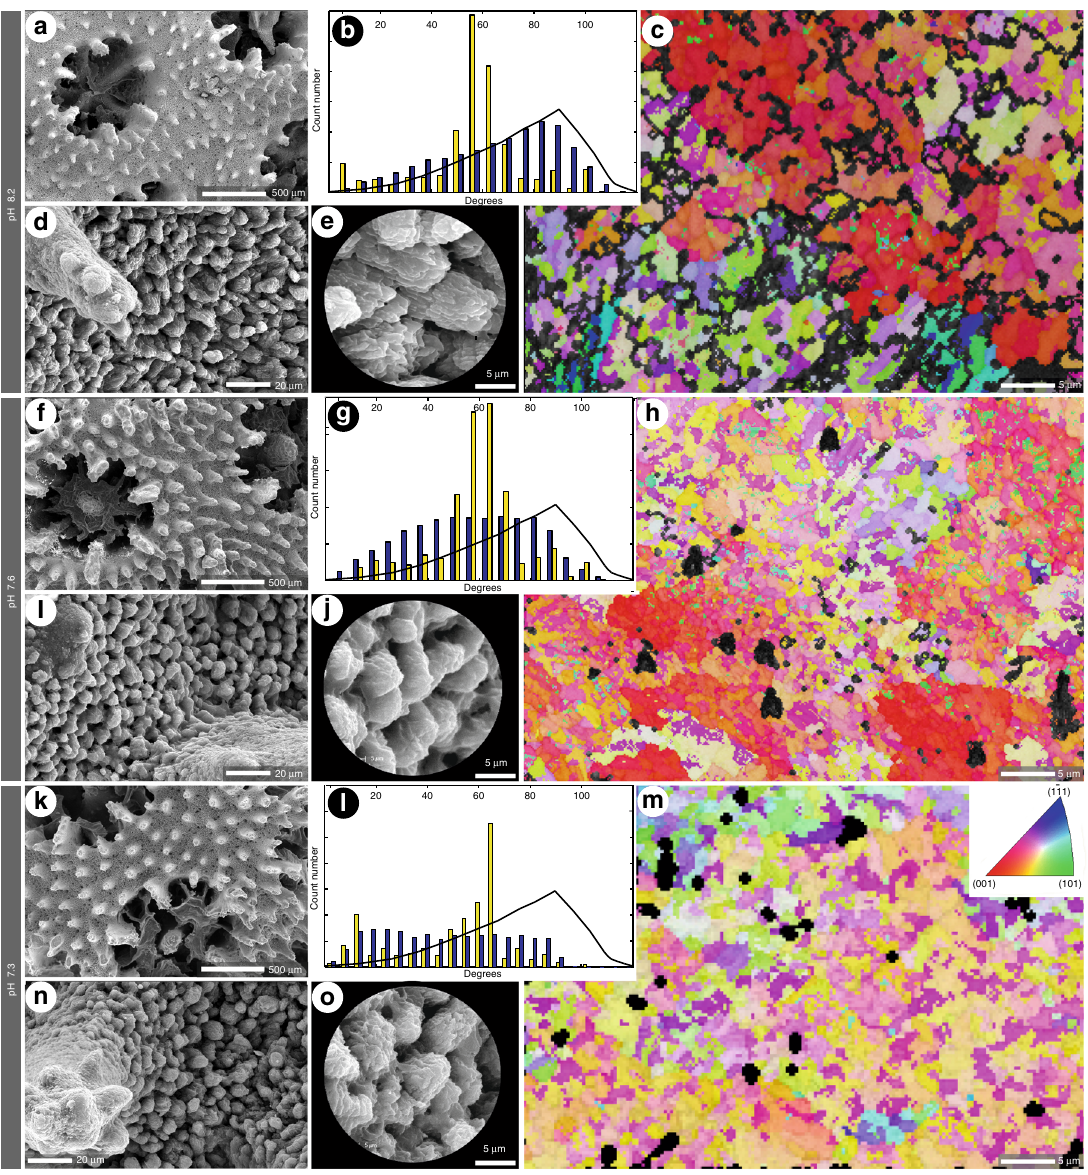
Fig. 1 Structural features of Stylophora pistillata cultured at pH conditions. Overall view of the colony surface with corallites and spiny coenosteum ( a , f , k ). Enlargements of the coenosteum showing granulated surface composed by bundles of fi bres ( d , i , n ; details of the texture of bundles in zoomed areas ( e , j , o ). Note that the texture of bundles grown in 7.3 pH and 7.6 is more rounded than those grown in pH 8.2. EBSD orientation maps showing the crystallographic arrangement of thickening deposits crystals ( c , h , m ). Colour-coding assigns a colour to each possible orientation. Histograms ( b , g , l ) representing correlated (yellow bars) and uncorrelated (blue bars) misorientation of crystals (black line represents random distribution computed for this crystal symmetry). Correlated misorientation describes fi bre-to- fi bre relationships (in contact), whereas uncorrelated misorientation described relationships between fi bres without direct contact (e.g., between different bundles). Misorientation is measured regardless of coral sectioning (morphological orientation of aragonite fi bre